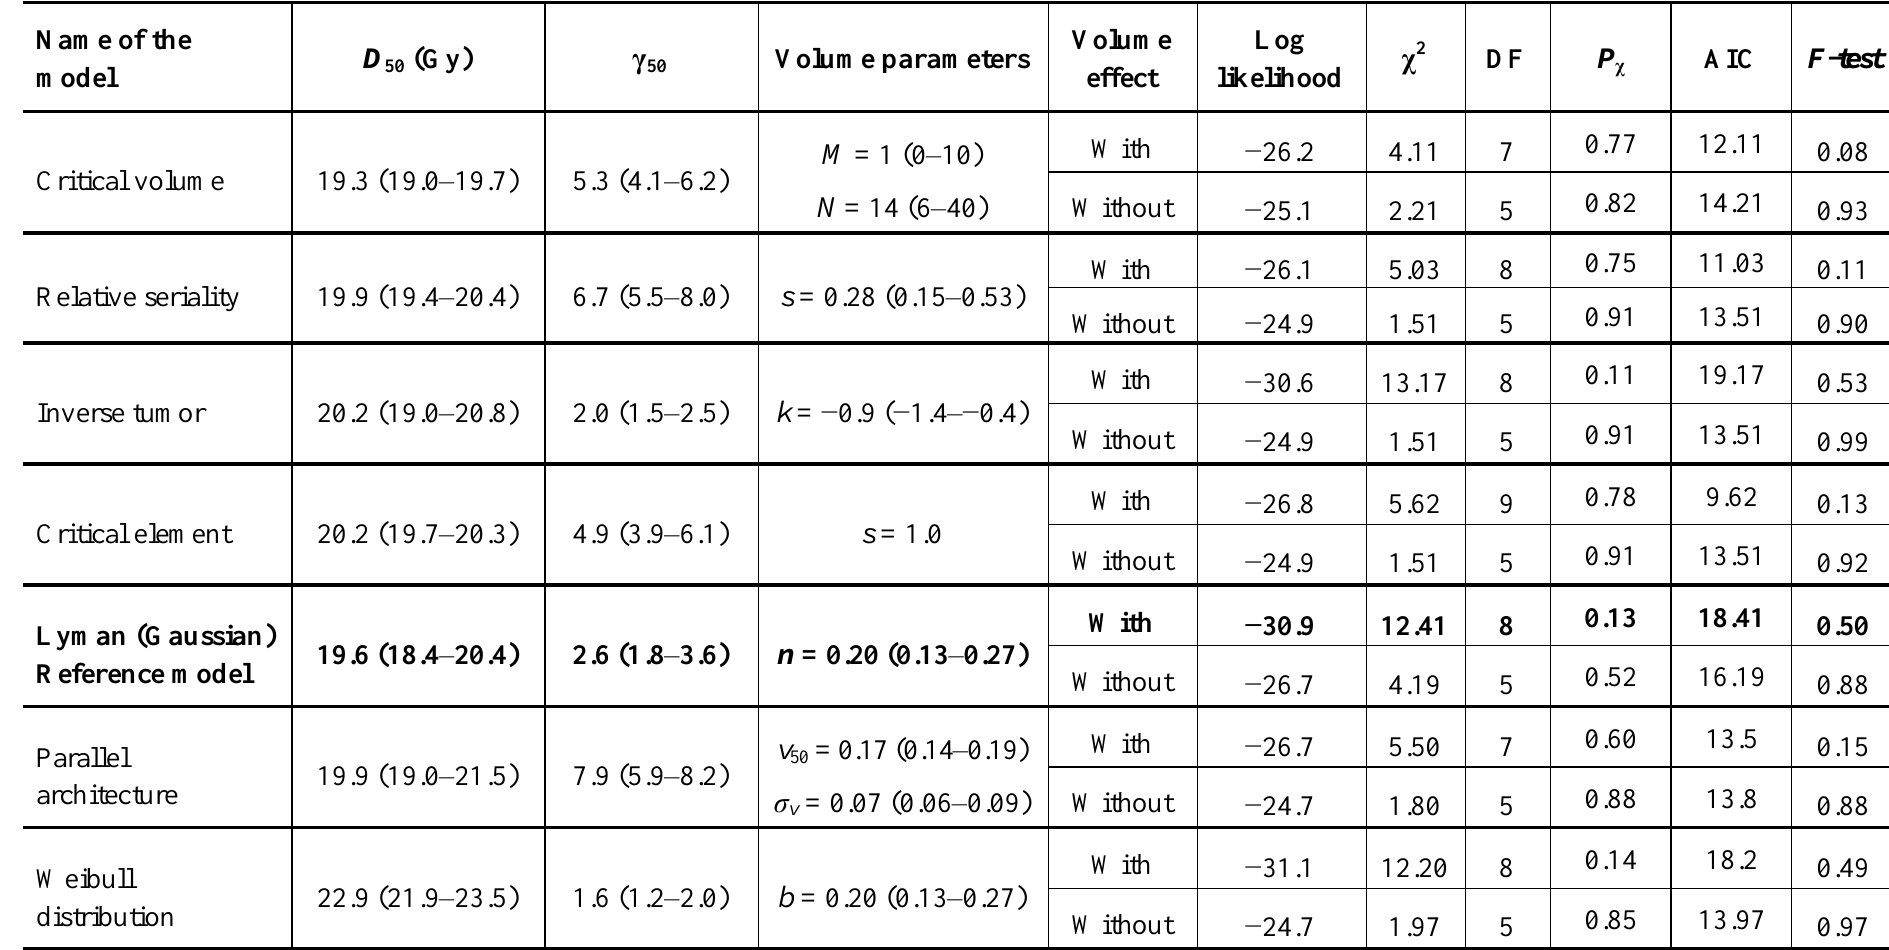
Table 4. Model parameter values for vascular